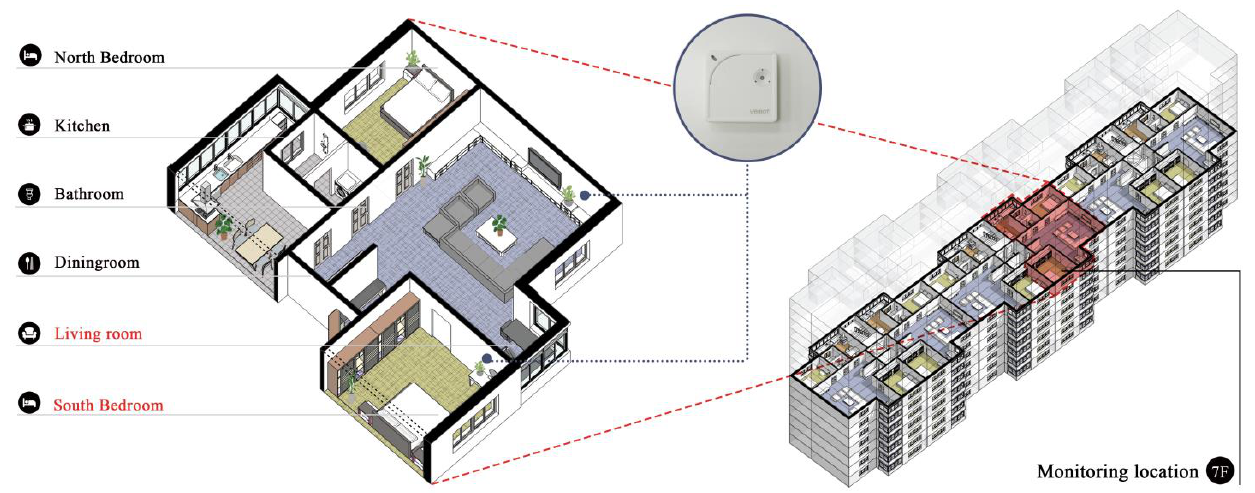
Figure 3. Locations of sensors for indoor temperature measurement; photograph of the applied sensor shown in the circled portion.